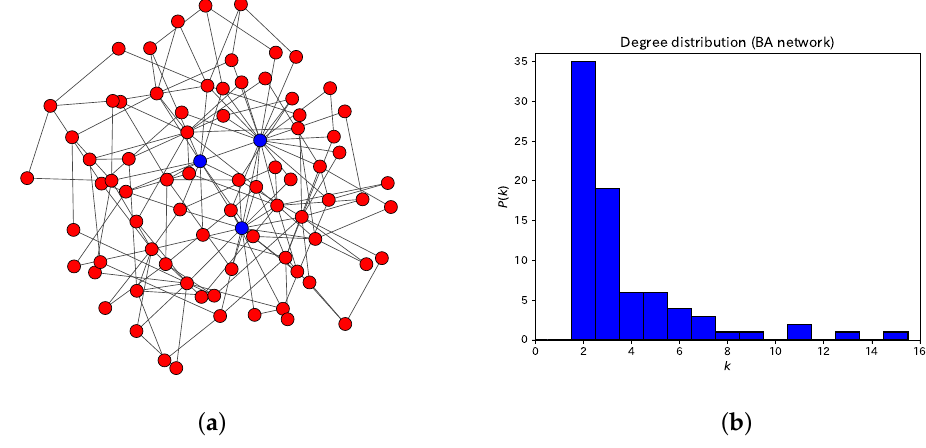
Figure 2. BA network; N = 80, (cid:104) k (cid:105) = 4. ( a ) Graph. ( b ) Distribution of